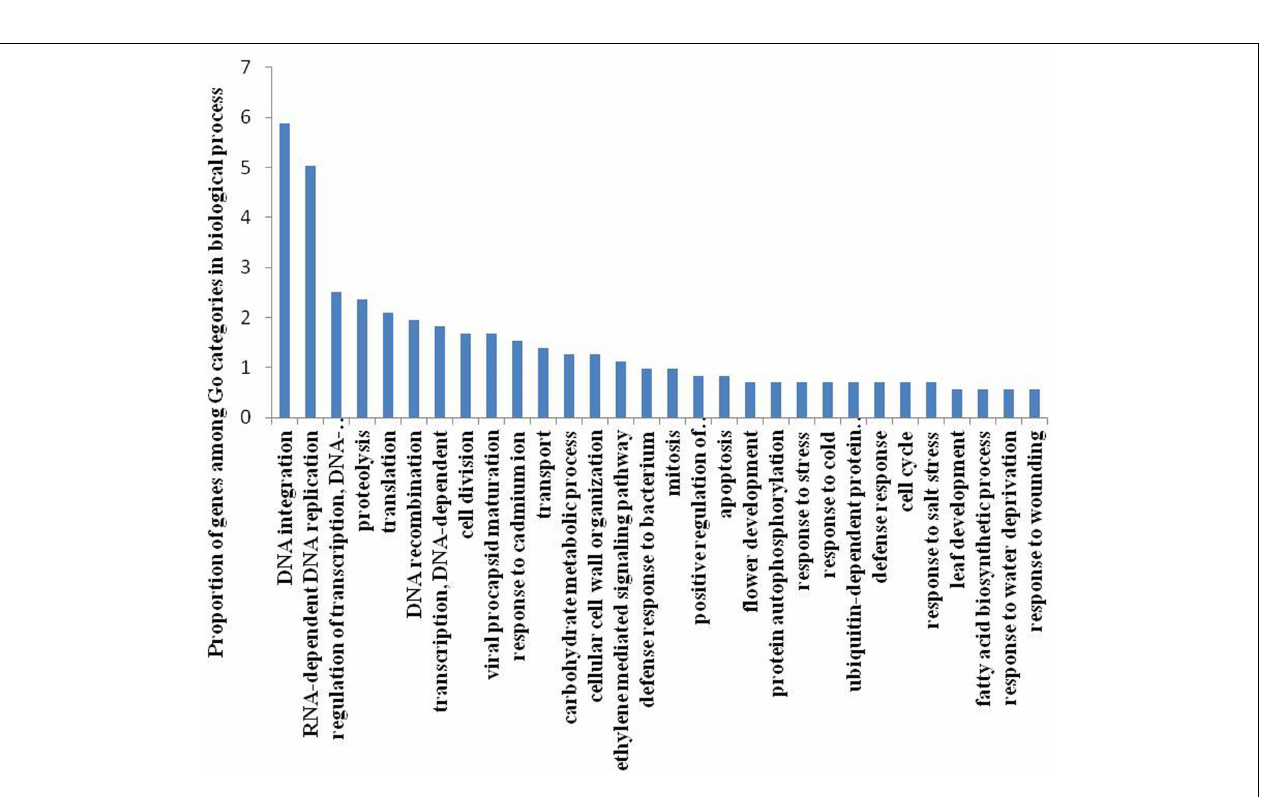
terms was analyzed using GO slim assignment. The x-axis and y-axis indicate the names of clusters and the percentage of each cluster,